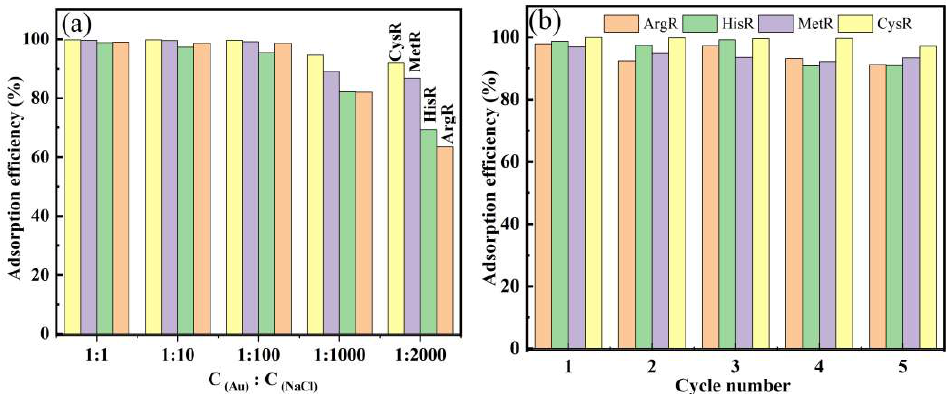
Figure 6. Effect of NaCl on Au(III) ion adsorption by amino acid resins ( a ) and adsorption–desorption process ( b ) (adsorbent mass = 10 mg, pH = 2, V = 10 mL, T = 30 °C, contact time = 24 h).